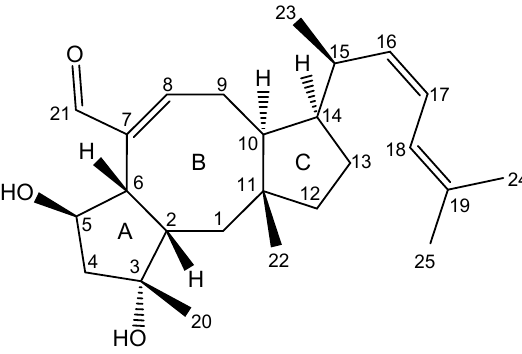
Figure 9. Structure of ophiobolin